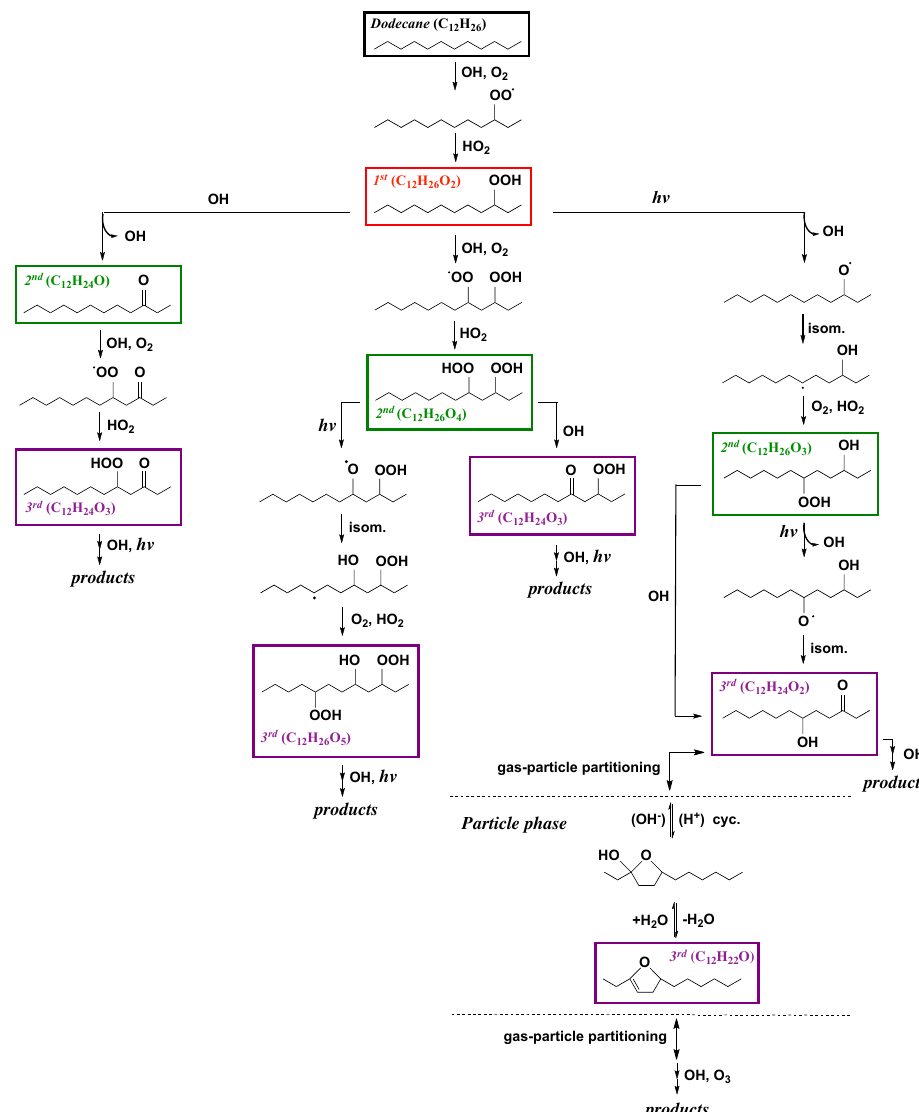
Fig. 1b. Schematic mechanism for the photooxidation of dodecane under low-NO x conditions. Note that only the first three generations of products are shown here. The boxes indicate compounds and associated reaction pathways incorporated in the model simulation.